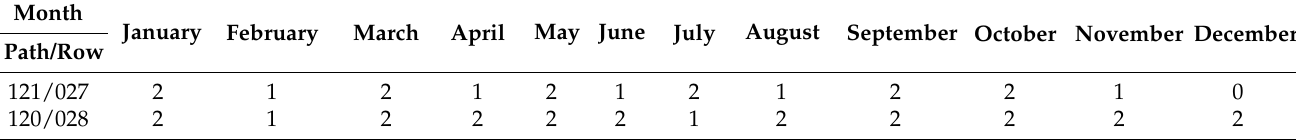
Table 1. The number of Landsat 8 images per month for the study area in